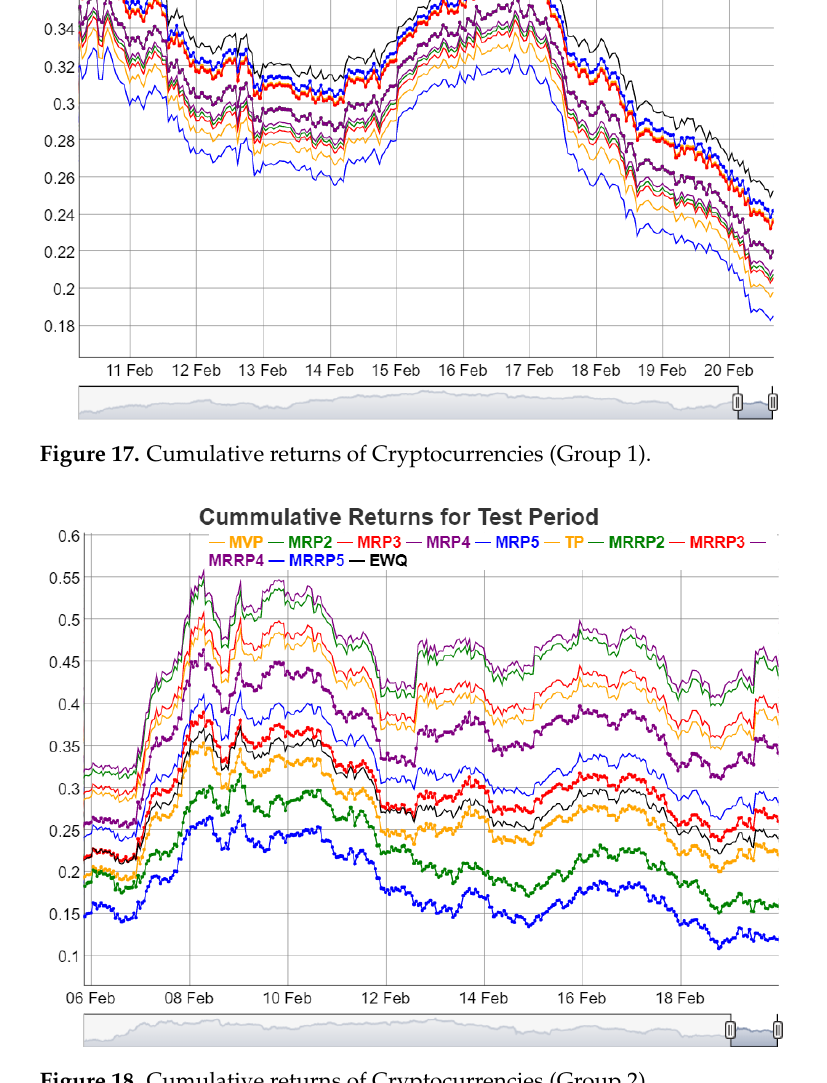
Figure 18. Cumulative returns of Cryptocurrencies (Group